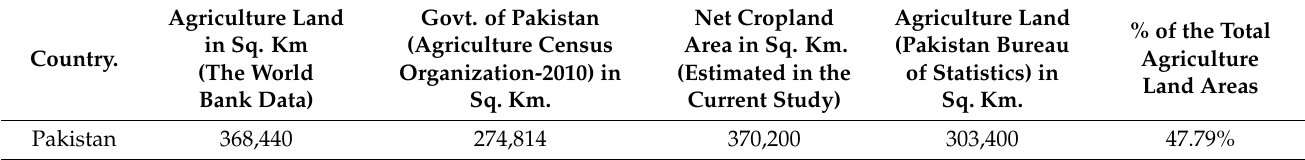
Table 5. Net cropland areas derived based on the 10 m to 60 m Sentinel-2 MSI.